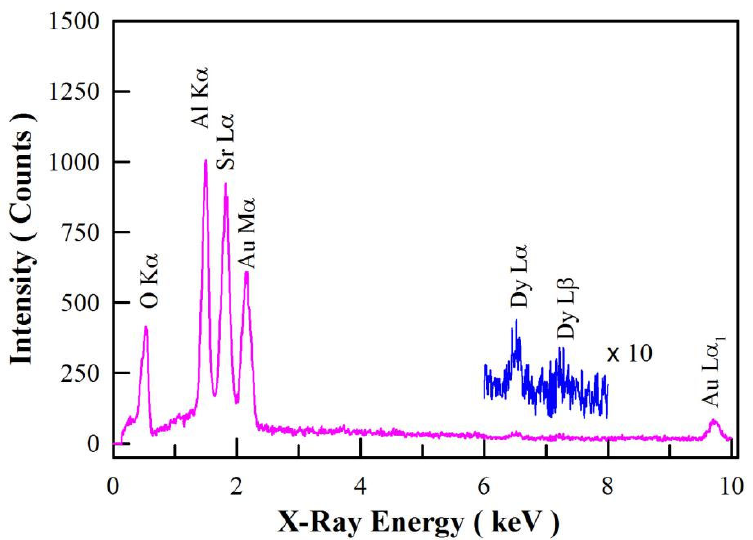
Figure 3. EDX spectrum of SrAl 2 O 4 :Dy 3+ (1.6 mol%) after Mn 4+ diffusion at 800 °C for 4 h.